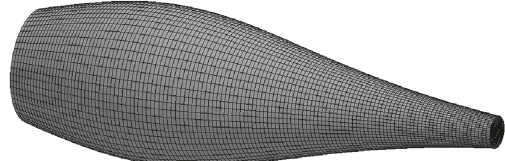
Figure 7: The finite element model of the